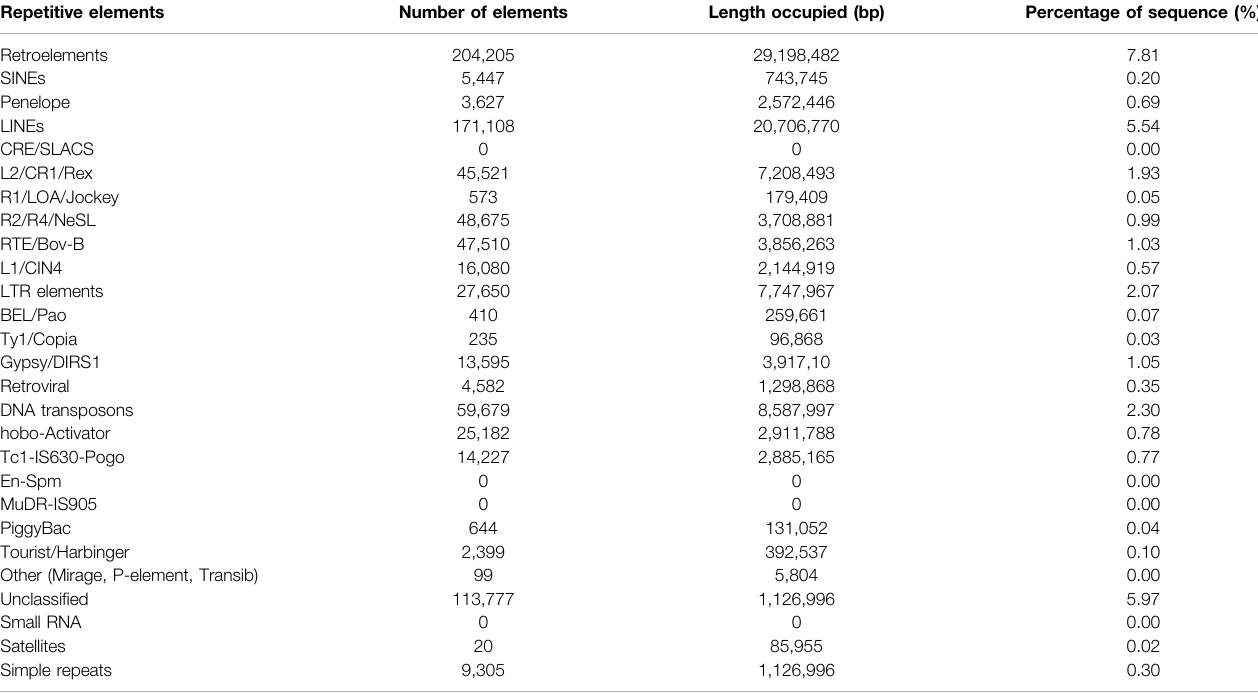
TABLE 3 | Repeat elements annotation statistics. Repetitive elements